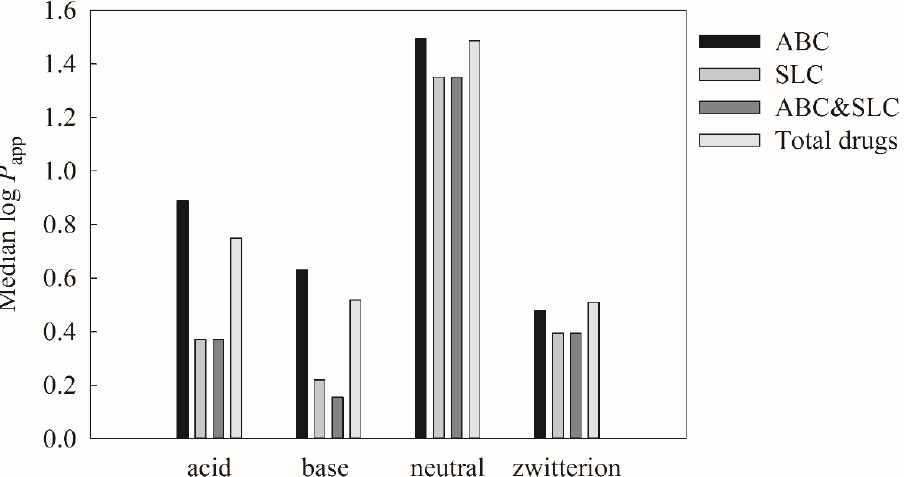
Figure 11. The histogram represents the log P app versus the molecules belong to ATP-binding cassette (ABC) substrate, solute carrier (SLC) substrate, both ABC and SLC substrate, and total drugs in the acid class, base class, neutral class, and zwitterion class, respectively.